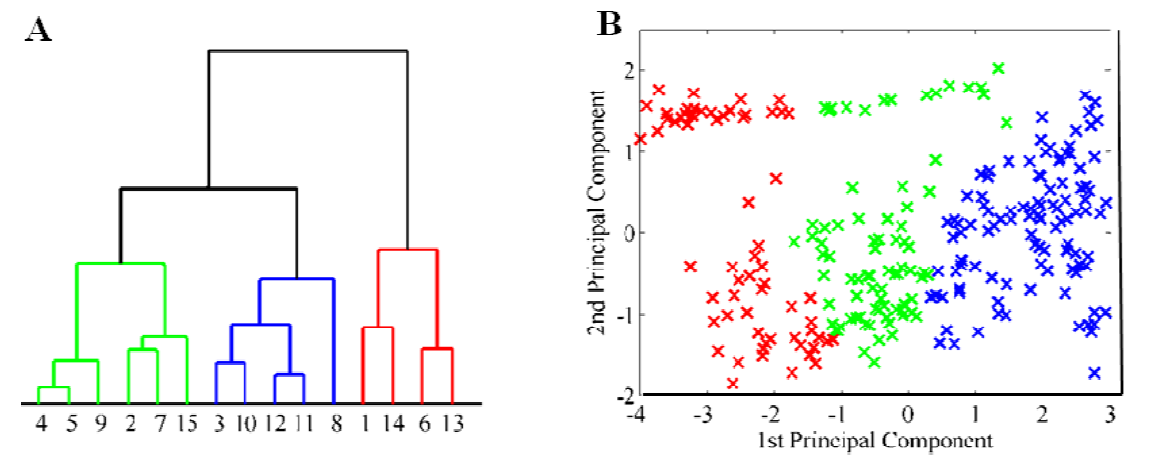
Figure 8. ( A ) Statistical clustering of apricot cultivars according to their antioxidant activity. All apricot cultivars were clustered into three clusters; ( B ) Three-dimensional projection of the clusters to distinguish their